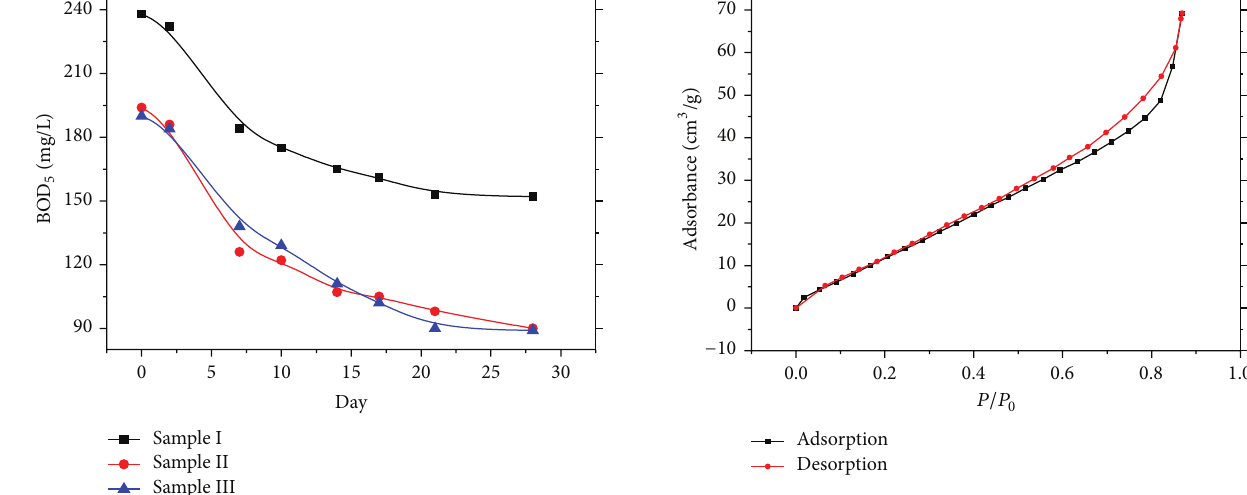
Figure 5: The curve of BOD 5 of sewage sludge.